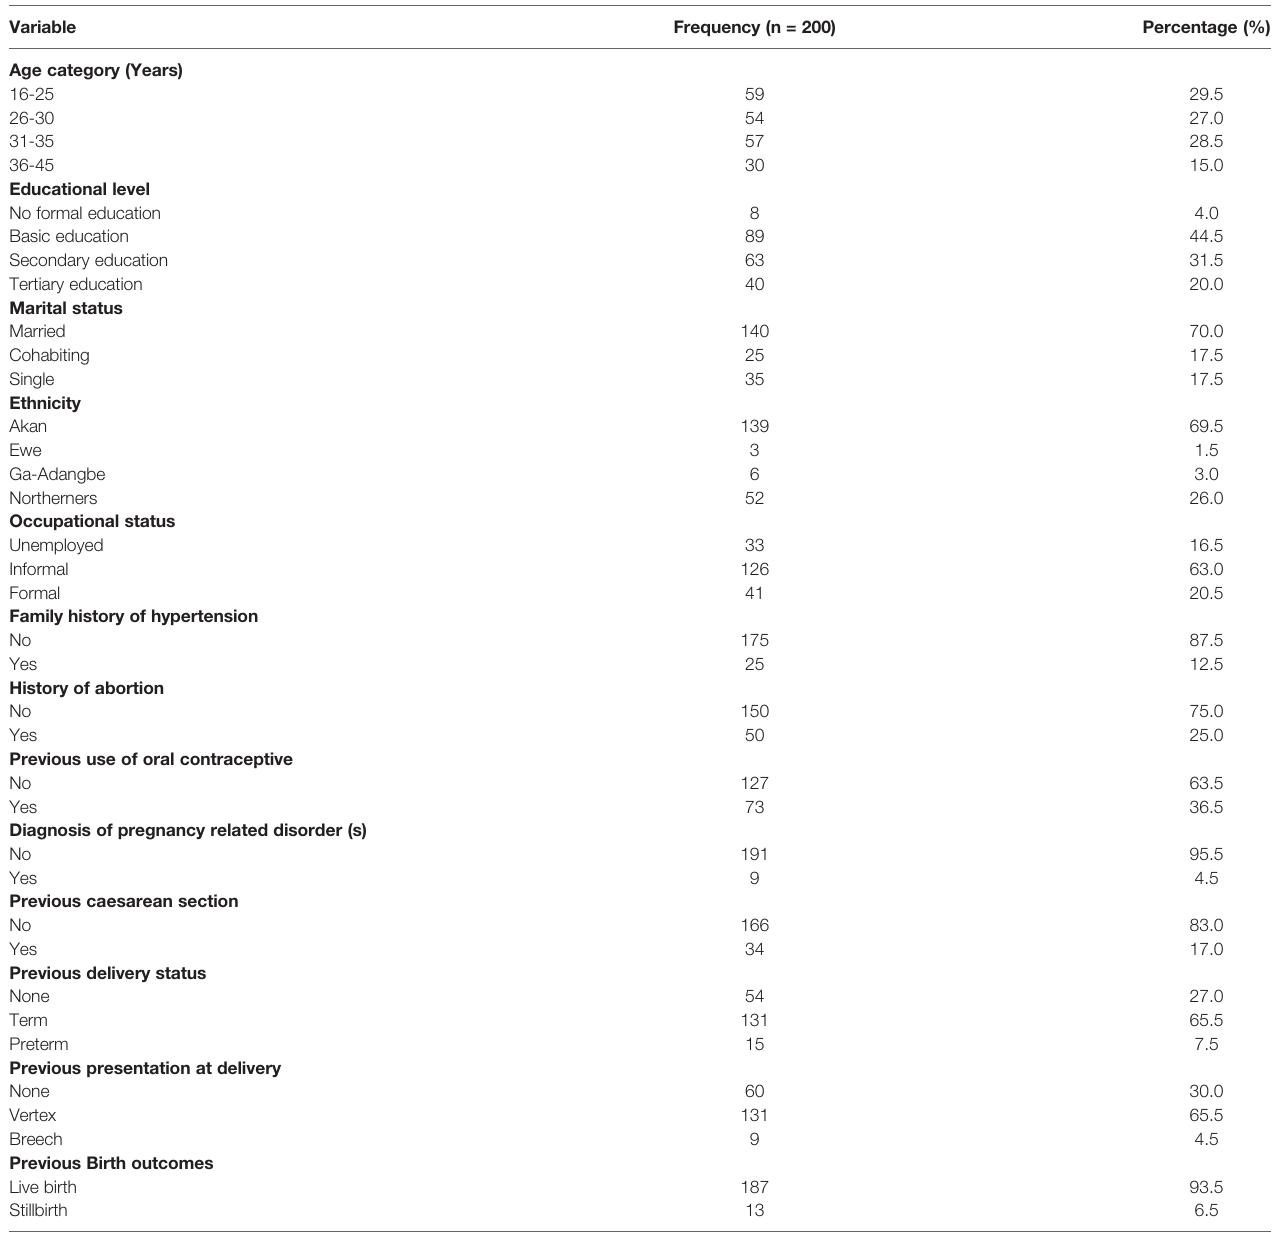
TABLE 1 | Baseline characteristics on socio-demographics and obstetric risk